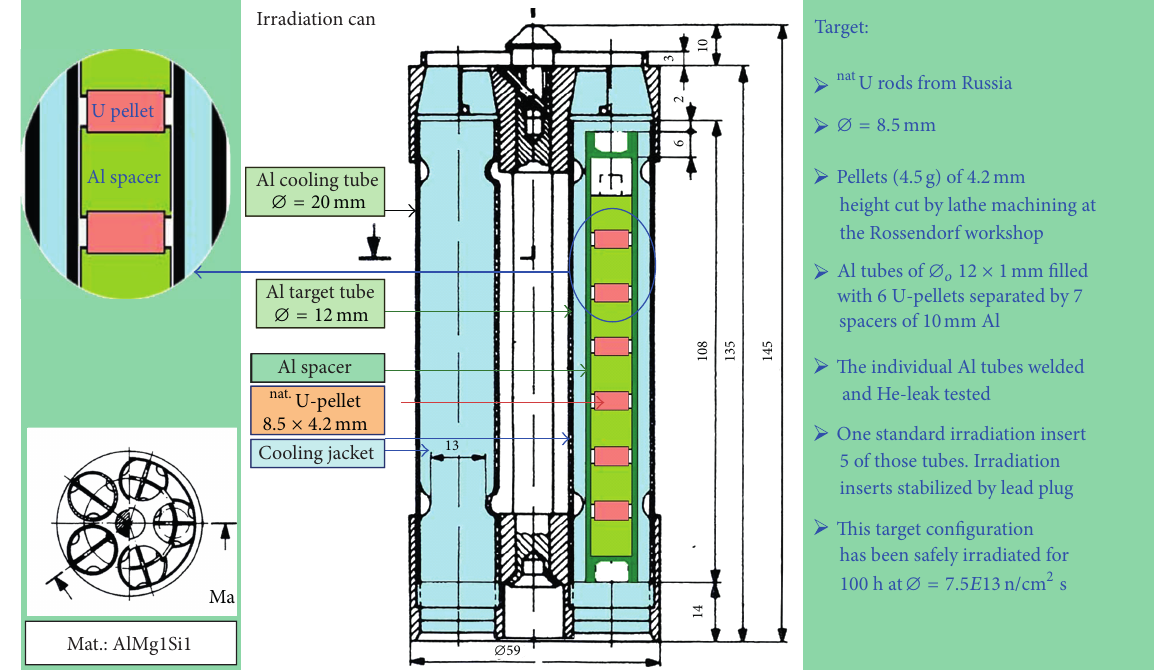
Figure 1: General design of an irradiation can with five very low enriched targets for fission Mo-99 production (taken from [18]).